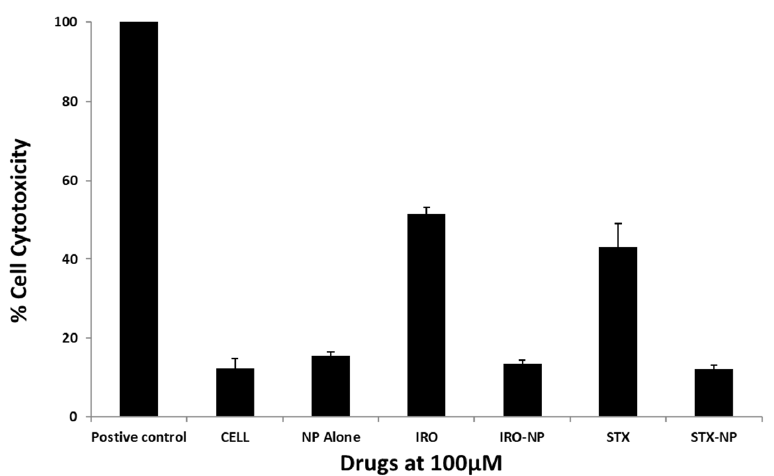
Figure 7. The toxicity of these chemicals towards human cells was assessed using cytotoxicity tests. All of the drugs used showed quite negligible cytotoxicity. The findings are shown as the mean ± sem.